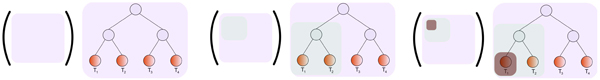
Example of a hierarchical decomposition. According to a simple binary tree, it is shown how each node defines a subset of tasks (a block in the corresponding kernel matrix on the left). Here, the decomposition is shown for only one path: The subset defined by the root node contains all tasks, the subset defined by the left inner node contains t1 and t2 and the subset defined by the leftmost leaf only contains t1. Accordingly, each of the remaining nodes defines a subset Si that contains all descendant tasks.